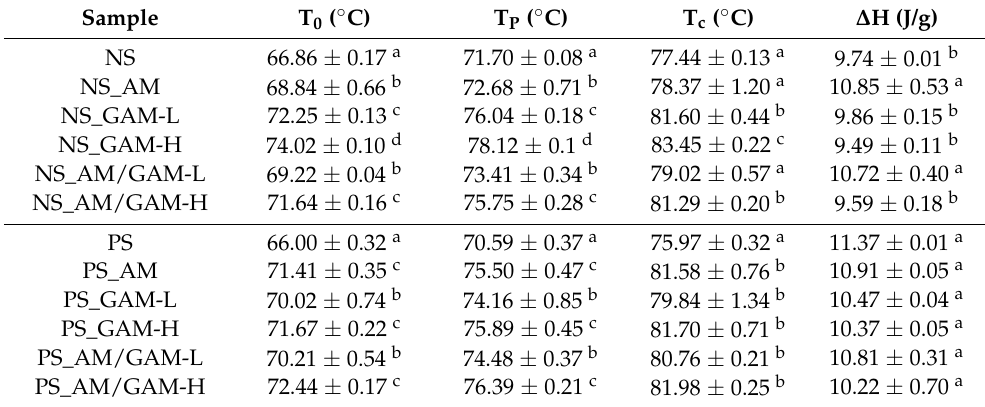
Table 4. Thermal properties determined by DSC of the produced porous